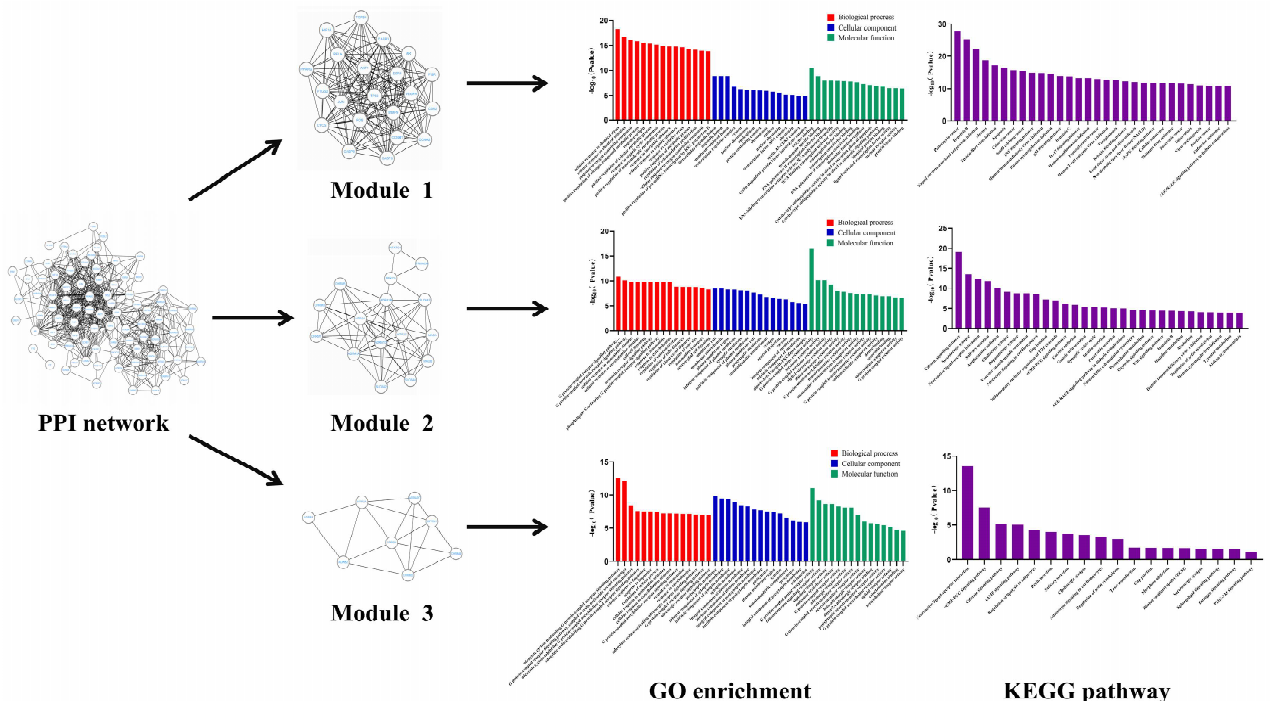
Figure 3. Analysis of PPI Network Module On the left is the PPI network diagram. Which is divided into three modules pointed by the arrow through the MCODE plug-in, and then carries on the GO function additional analysis and KEGG path enrichment analysis to each module. In the GO function enrichment analysis, the three types of GO function annotations of BP, CC, MF are distinguished by using different